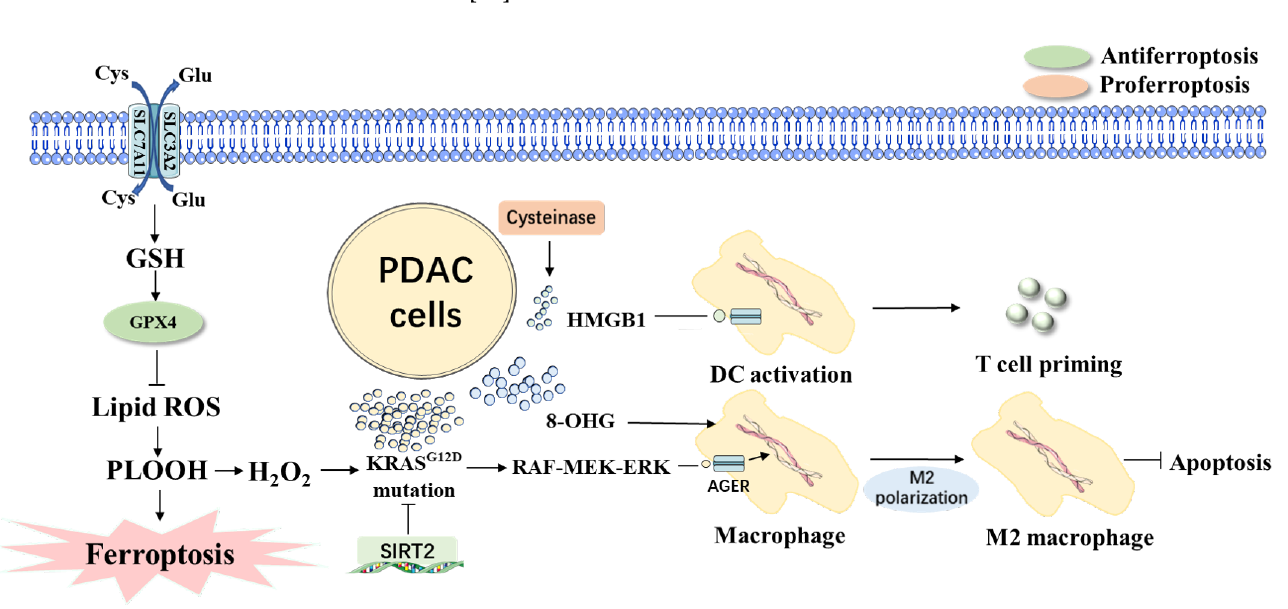
Figure 2. KRAS of ferroptosis in PDAC. The depletion of GPX4 or the release of H 2 O 2 from PLOOH causes the release of 8-OHG, which leads to the activation of cytokine production in macrophages and promotes tumor growth. Ferroptotic PDAC cells can also release the KRAS G12D protein, activating the RAS-RAF-MEK-ERK pathway, thereby inducing AGER-dependent macrophage M2 polarization and producing immunosuppressive cytokines in the tumor microenvironment and inhibiting apoptosis from promoting tumor cell growth. By contrast, the depletion of SLC7A11 in PDAC cells or the administration of cyst(e)inase suppresses tumor growth by releasing HMGB1 to initiate T cells and thus generate antigen-specific adaptive immune responses. Abbreviations: 8-OHG, 8-hydroxy-2 (cid:48) -deoxyguanosine; AGER, advanced glycosylation end product-specific receptor; GPX4, glutathione peroxidase 4; GSH, glutathione; H 2 O 2 , hydrogen peroxide; HMGB1, high mobility group box 1; PDAC, pancreatic ductal adenocarcinoma; SLC7A11, solute carrier family 7 member 11; PLOOH, phospholipid